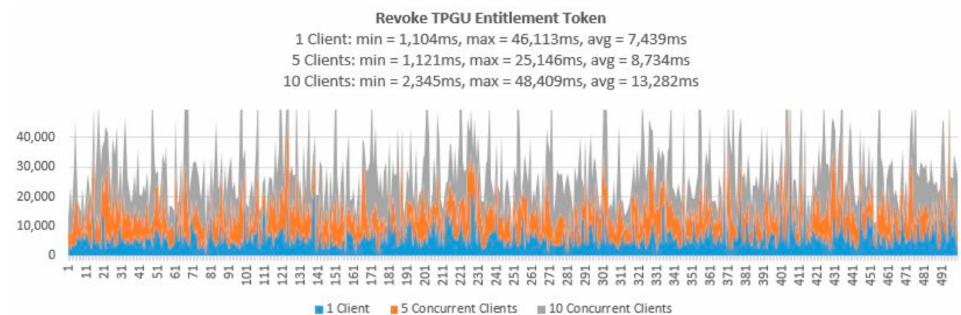
Figure 18. Response times from Revoke TPGU Entitlement Token for 500 calls.